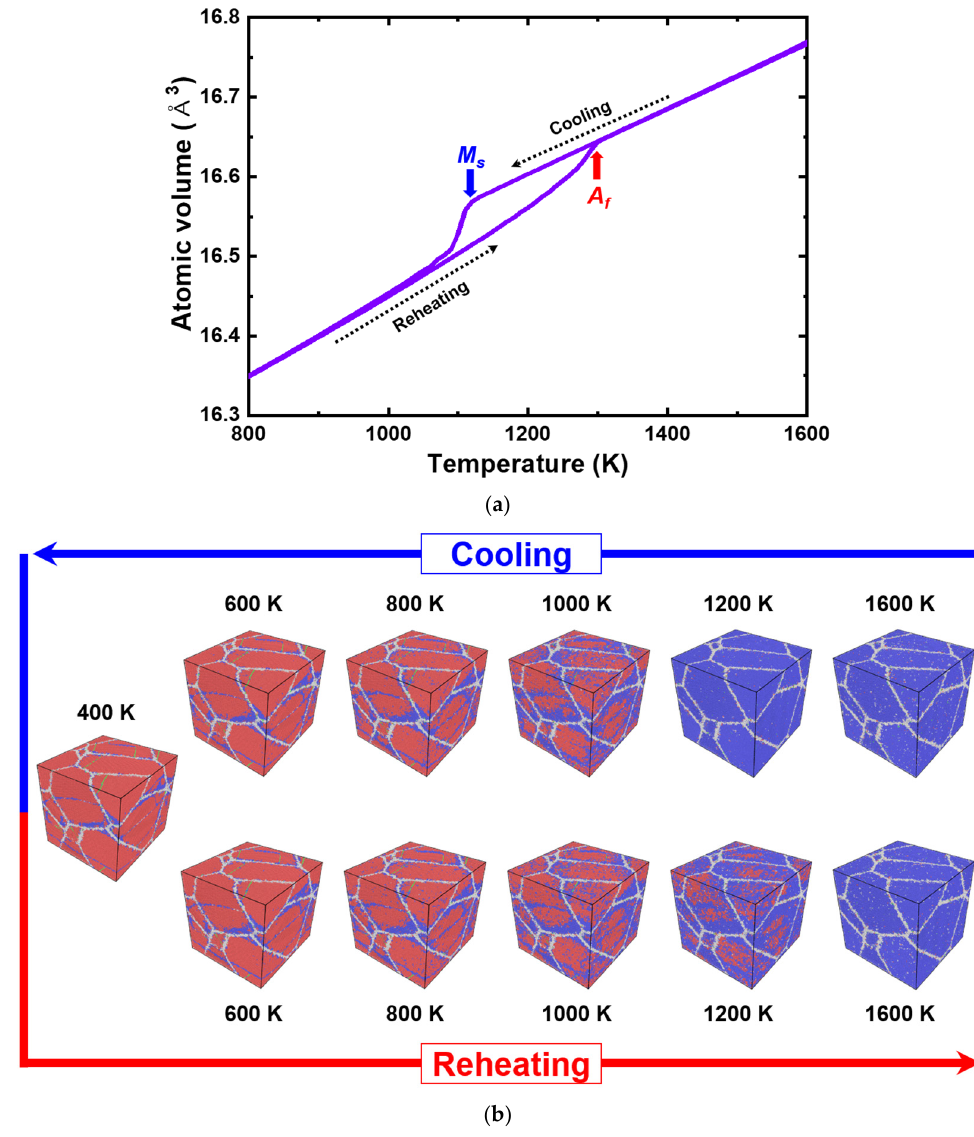
Figure 9. ( a ) Atomic volume vs. temperature plot of nanocrystalline equiatomic PtTi with five grains predicted using the present interatomic potential. The determined martensite start ( M s ) and austenite finish ( A f ) temperatures are indicated with blue and red arrows, respectively. ( b ) The corresponding atomic configurations are colored according to the PTM method [95] at regular intervals. The blue atoms correspond to the B2 austenite structure, red atoms to the B19 martensite structure, green atoms to the twin boundaries, and gray atoms to the domain or grain boundaries.